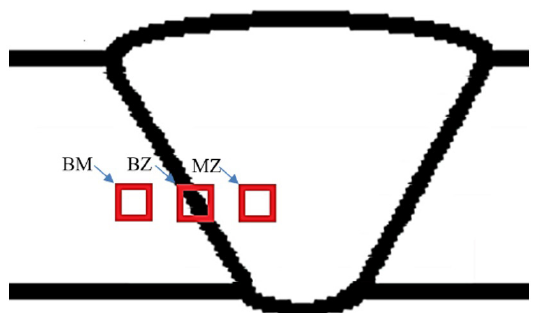
Figure 1. Schematic representation of the regions analysed from the weld macrography. BM represents the base metal, BZ represents the bonding zone, and MZ represents the molten zone. The heat-affected zones are the regions between the bounding and base-metal zones.